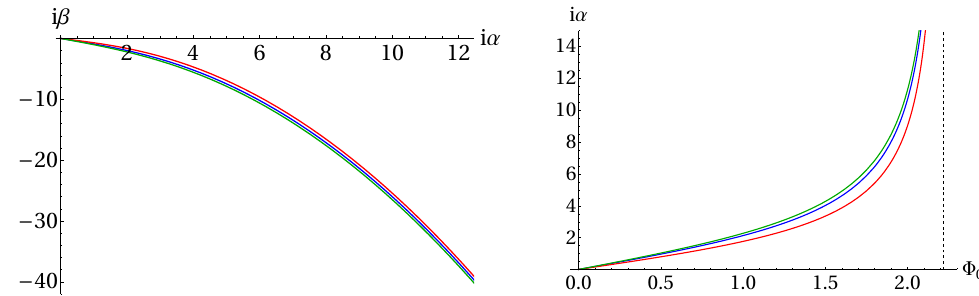
Figure 10. Left panel: the behavior of (cid:12) as a function of (cid:11) for di(cid:11)erent degrees of anisotropy. Right panel: the behavior of (cid:11) as a function of (cid:8) 0 . All curves have B = 0. The blue curve has A = 5, the red one A = 40 and the green one A = (cid:0) 0 : 85. When (cid:8) 0 !